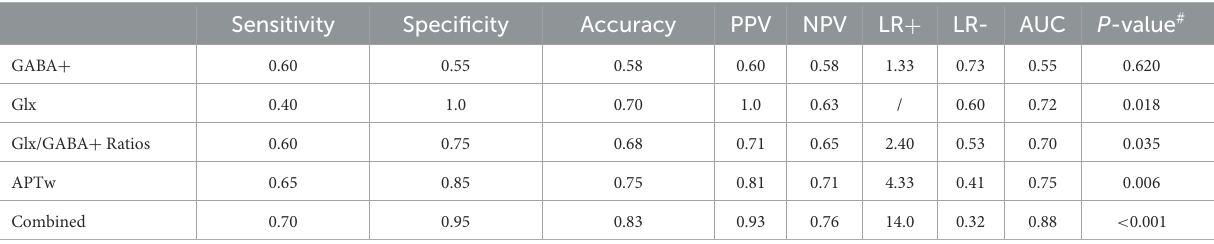
TABLE 4 Diagnostic performance of right hippocampal